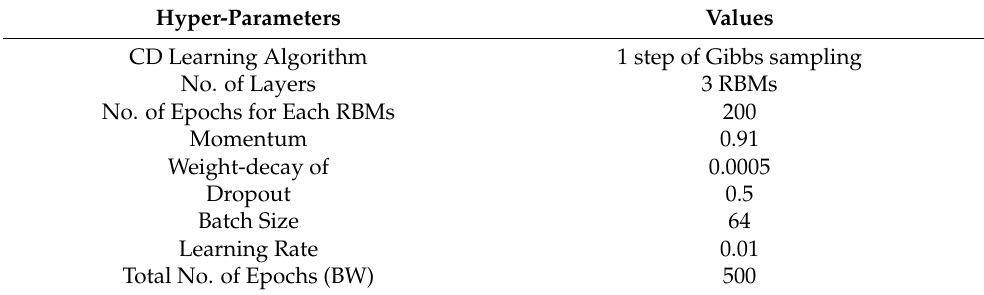
Table 5. The values of the hyper-parameters for the best obtained DBN model for addressing person ReID